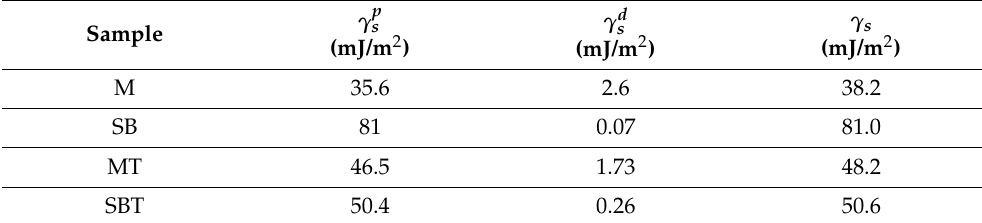
Table 3. Surface energy for pretreated and thermally treated Ti64 specimens.